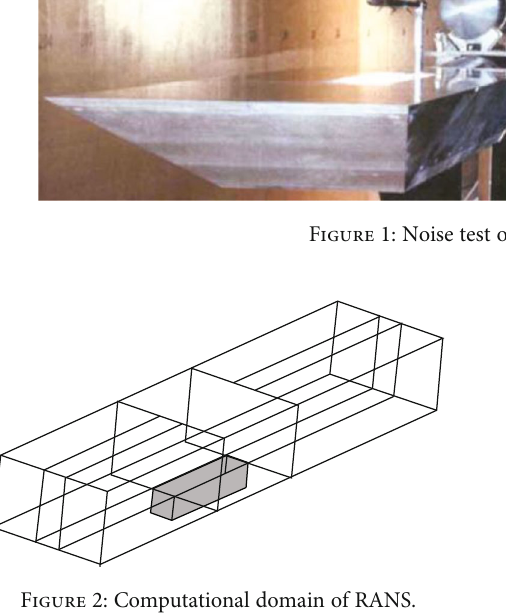
max calculated by RANS (shaded with